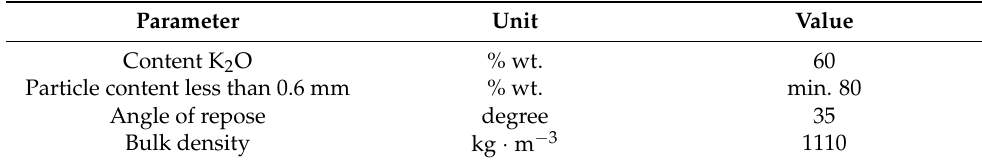
Table 2. Potassium salt—technical potassium